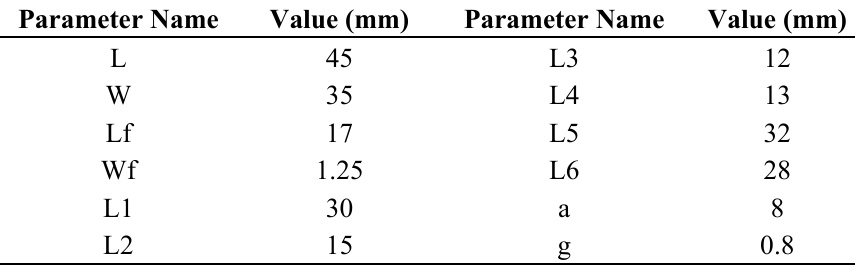
Figure 1. ( a ) Schematic diagram of the antenna; ( b ) Unit cell array and unit cell configuration. Table 1. Antenna design and unit cell